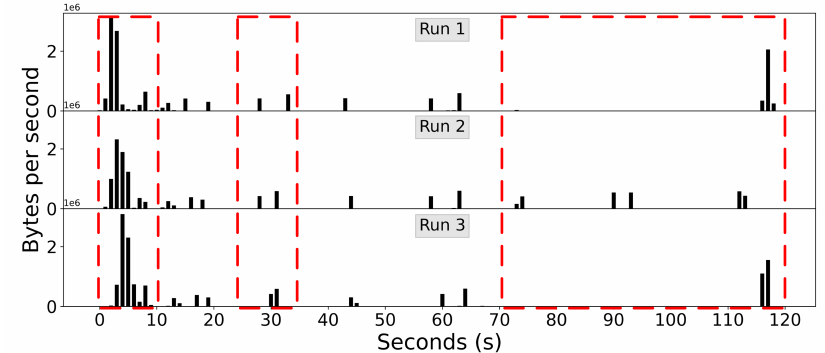
Figure 1. Abnormalities in streaming